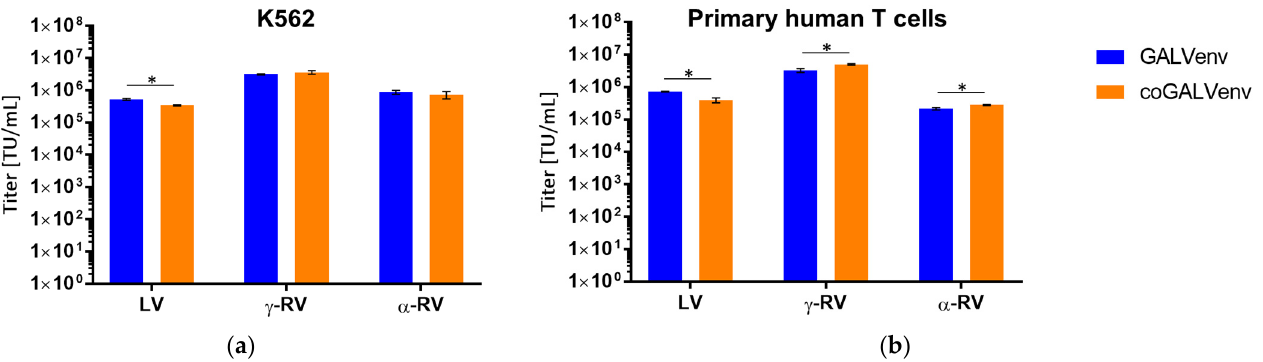
Figure 5. Titers of standard-scale produced supernatants of the three vector types (for LVVs, γ -RVVs, and α -RVVs) on K562 cells and primary human T lymphocytes. LVVs were produced with 640 ng and γ -RVV as well as α -RVV with 160 ng GALV-env plasmids per 10 6 producer cells. In contrast, for production of all coGALV-env vectors, only 20 ng of plasmid/10 6 cells was used. Titers were determined using dilution series on ( a ) K562 and ( b ) primary T lymphocytes. Shown are means of triplicates. TU = transducing units, * p < 0.01 ( t -test).